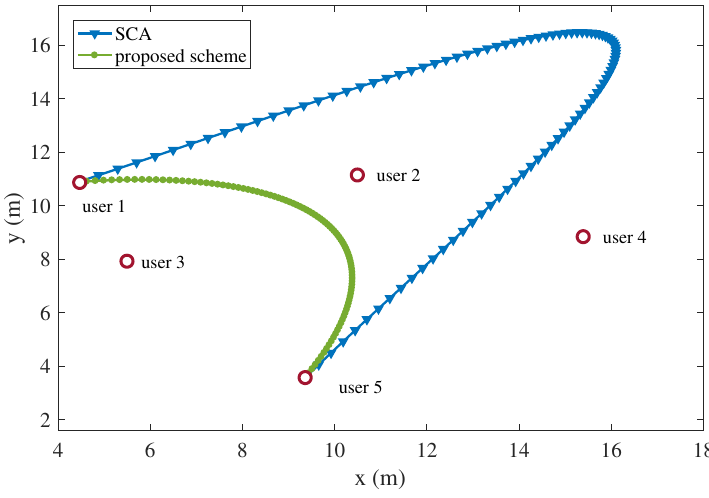
Figure 10. The trajectory of the UAV using the proposed scheme and the SCA scheme under the time constraint T = 5 s ( I 1 = I 3 = I 5 = 2 × 10 7 bits, I 2 = I 4 = 8 × 10 7 bits).